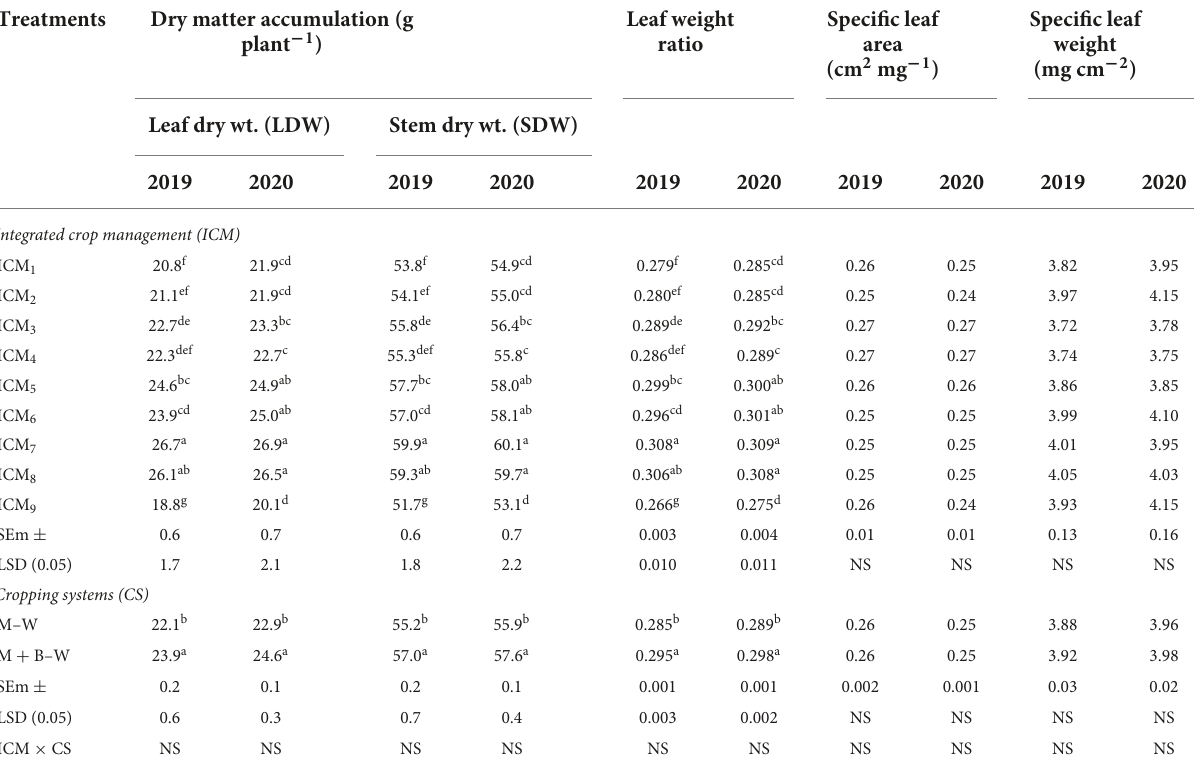
TABLE 7 Effect of ICM modules and cropping system on dry matter accumulation and leaf growth parameters of maize at flowering stage a .